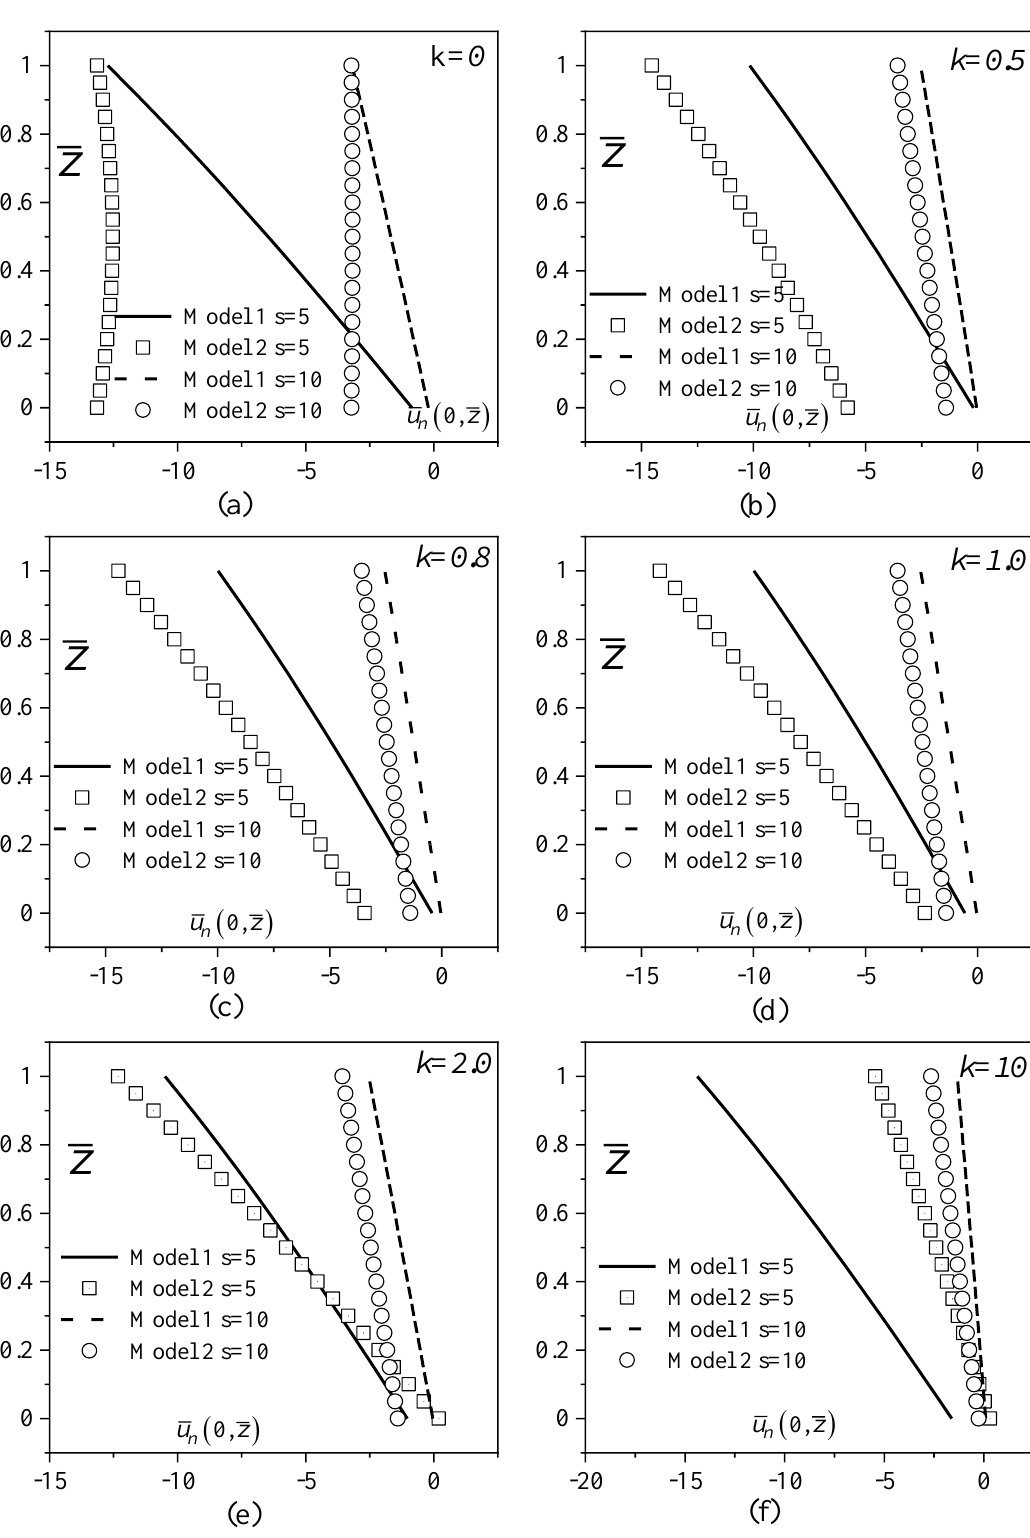
Fig. 5. Thickness variation of normalized in-plane displacement (